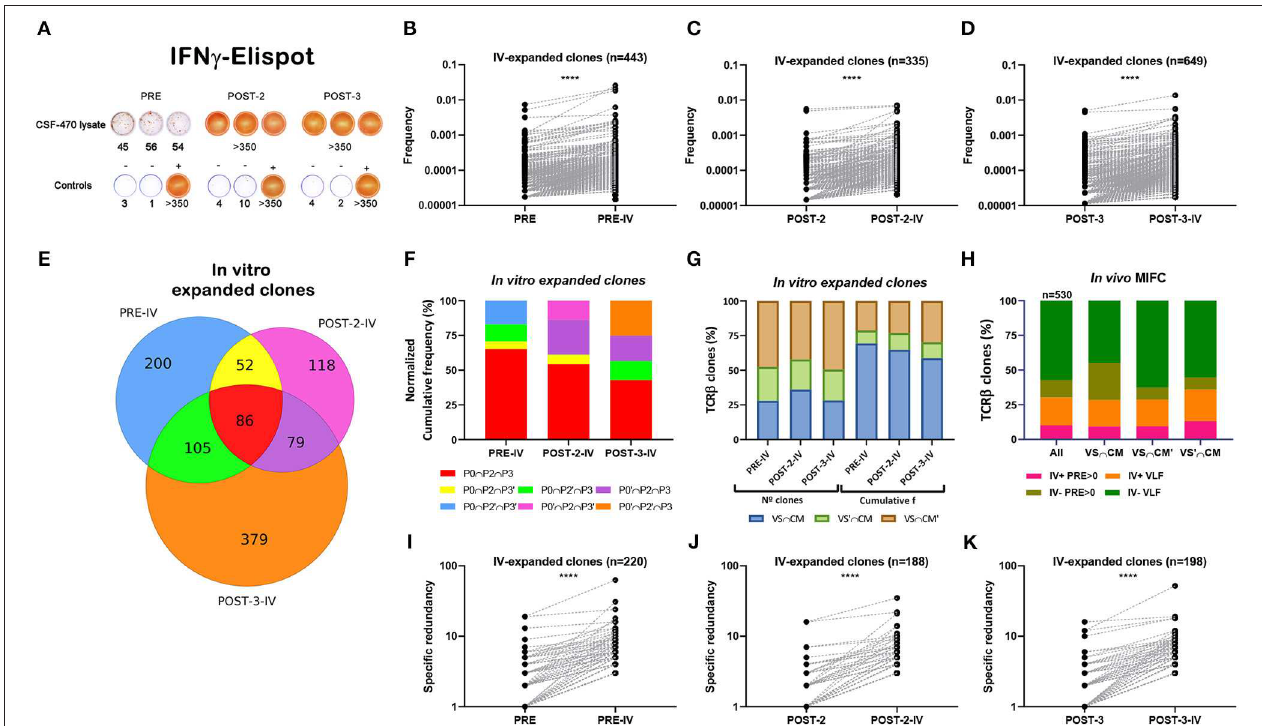
FIGURE 4 | Analysis of persistent in vitro expanded TCR β clones with CSF-470 vaccine Ags. (A) PBMC were stimulated in vitro ( iv ) with CSF-470-vaccine lysate and evaluated IFN- γ release by ELISPOT assay. Controls: PBMC with only culture medium (–), and with OKT3 plus PHA ( + ). (B–D) Paired-frequency of persistent iv- expanded TCR β clonotypes relative to their in vivo counterpart. (E) Venn diagram distribution of common persistent iv- expanded clones between PRE, POST-2, and POST-3 samples (expansion ≥ 10%). (F) Cumulative frequency distribution of common iv- expanded clones between the different samples. (G) N ◦ and cumulative frequency distribution of iv- expanded clones in VAC-SITE/C-MTS compartments. (H) Distribution of in vivo MIFC regarding their in vitro frequency-expansion (iv + , iv–) and their initial abundance (pre-existing basal clones; PRE > 0, and very-low-frequency clones, VLF), in VAC-SITE/C-MTS compartments. (I–K) Paired-specific redundancy of iv- expanded clones relative to their in vivo counterpart. Samples : PRE = P0 = PBMC-PRE; POST-2 = P2 = PBMC-POST-2; POST-3 = P3 = PBMC-POST-3. IV; iv : in vitro. All Wilcoxon test, **** p <